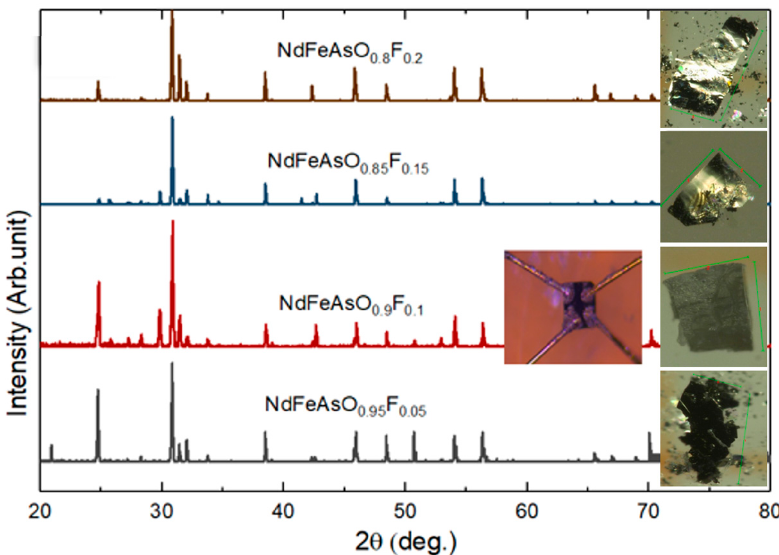
Figure 2. Powder XRD patterns for NdFeAsO 1-x F x with different fluorine doping, together with a piece of crystal sample of each grown system. The inset is an image of a crystal with four probes connected on the surface for transport measurements.